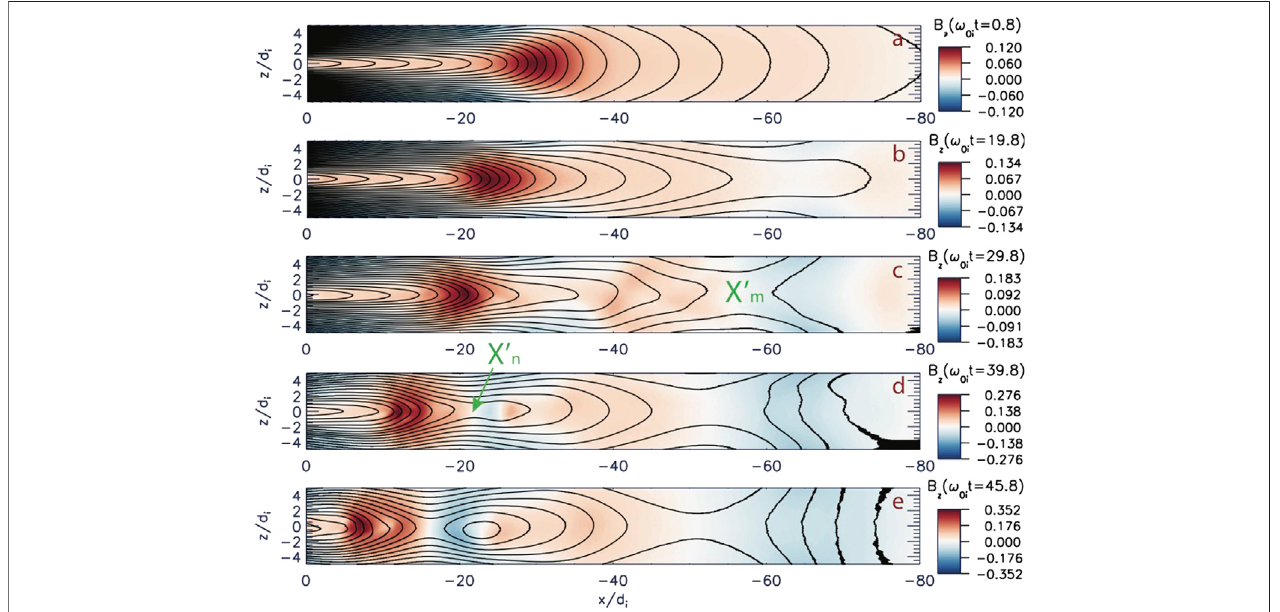
FIGURE 12 | (A) The initial magnetic fi eld con fi guration in PIC simulations of magnetotail reconnection, which isshown here as a color-coded distribution ofthe B z component with overplotted magnetic fi eld lines in the plane y (cid:1) 2 . 5 d i ( “ 2D-equivalent ” fi eld lines calculated by treating a slice of the 3-D domain as if it were a 2-D simulation). (B – E) magnetic fi eld distributions at later moments showing (B) the CSthinning, (C) the formation of the “ mid-tail ” X-line X m ′ , (D) another “ near-Earth ” X-line X n ′ near x (cid:1) − 20 d i , (E) the fully developed tail reconnection picture at the moment, which is further explored in more